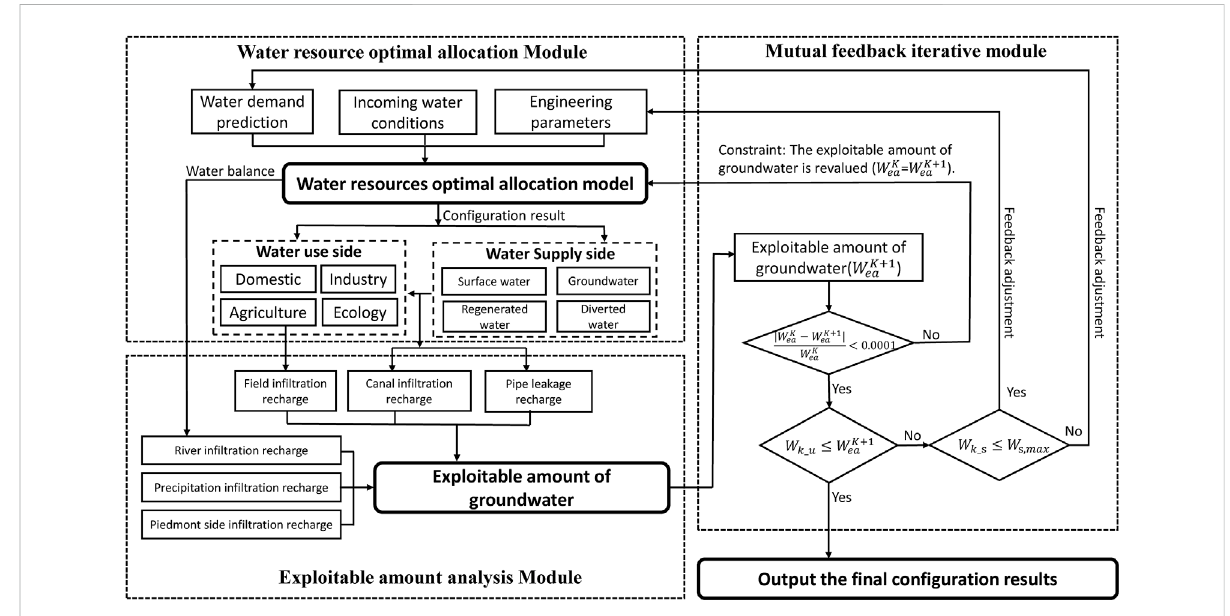
FIGURE 1 Framework of the proposed